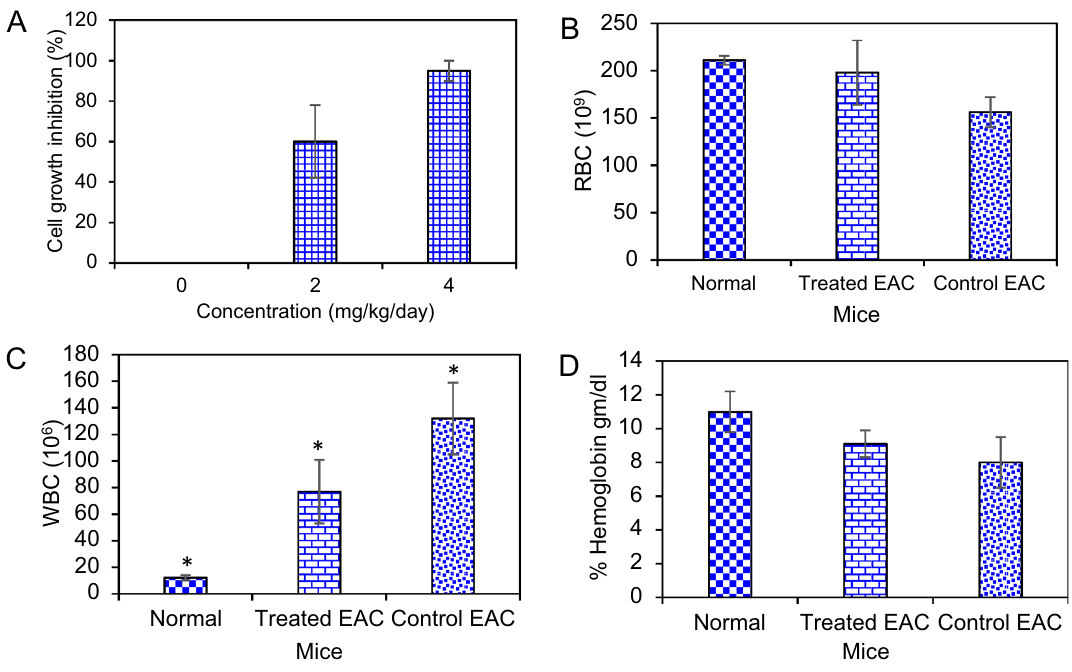
Figure 6. Cells growth inhibition and hematological parameter. ( A ) The number of EAC cells was counted in EAC-control and G. densiflorum -Ag/AgCl-NPs treated EAC-bearing mice. ( B ), ( C ) and ( D ) indicate the changes in RBC, WBC and % of hemoglobin after treatment with the nanoparticles. * P <